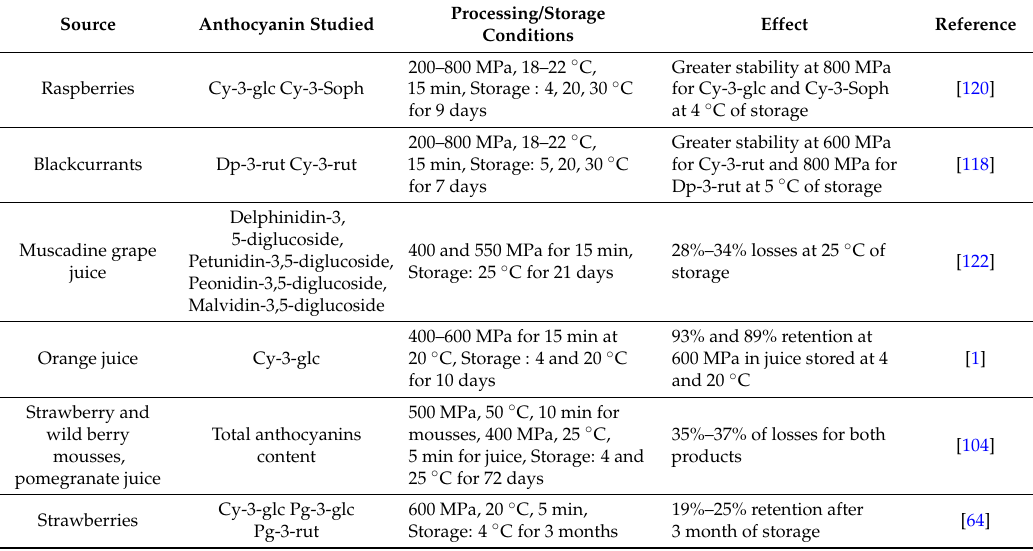
Table 4. Effect of HPP on the anthocyanins stability during